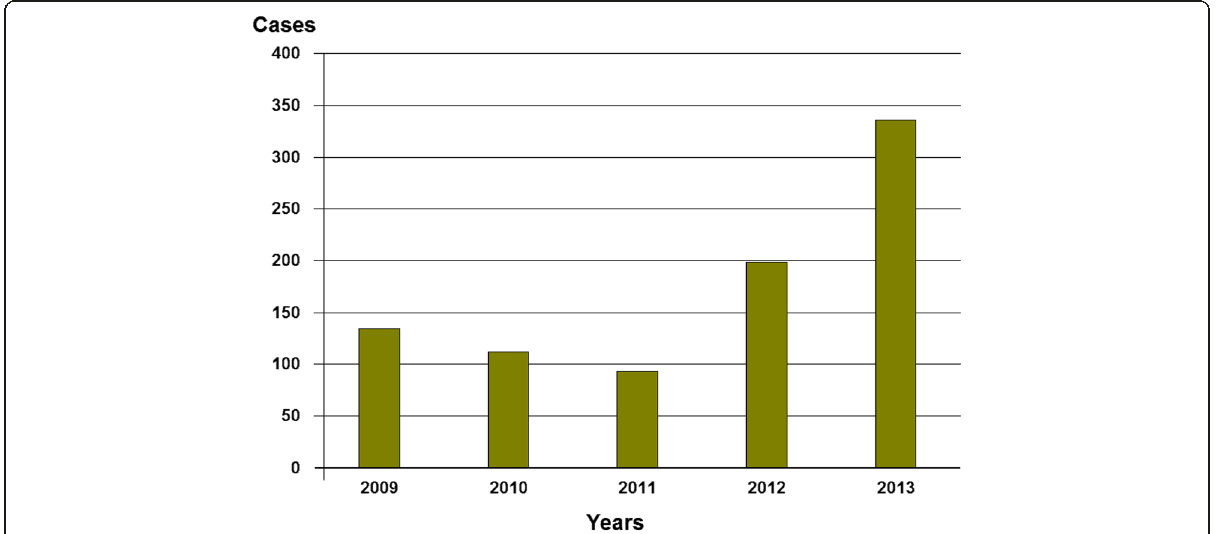
Fig. 1 Number of snakebites according to years, from 2009 to 2013 (data from